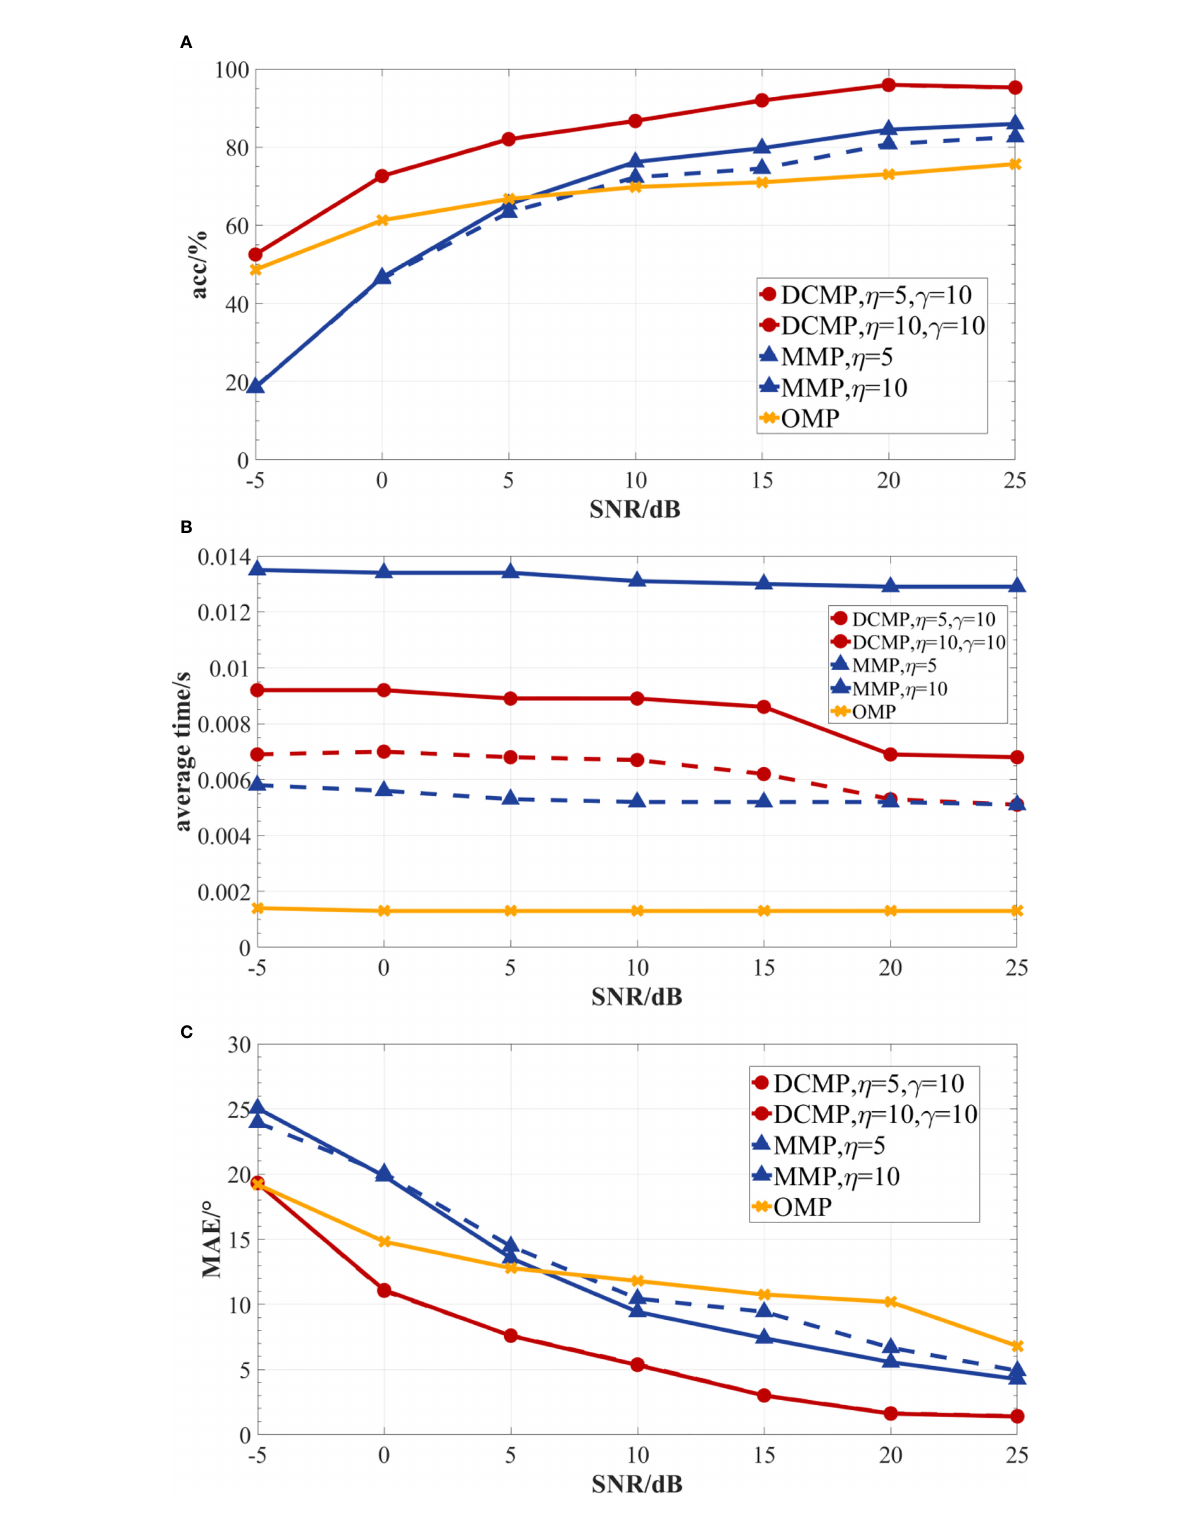
FIGURE 8 The performances of the DCMP, MMP, and OMP algorithms under different SNR values for two sources, a 12-element array, and 96 snapshots. (A) DOA prediction accuracy; (B) average estimation time; (C)